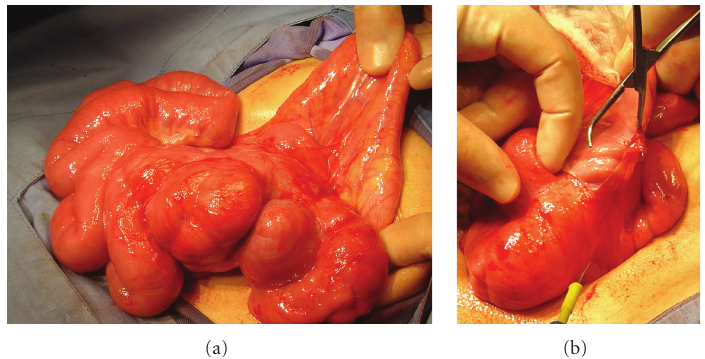
Figure 2: (a) Operative findings in patient 1, showing a foreshortened small bowel encased in a firm, rigid, fibrous membrane firmly ad- herent to the bowel. (b) View following incision of the membrane, revealing compressed, coiled, distended small bowel loops with interloop